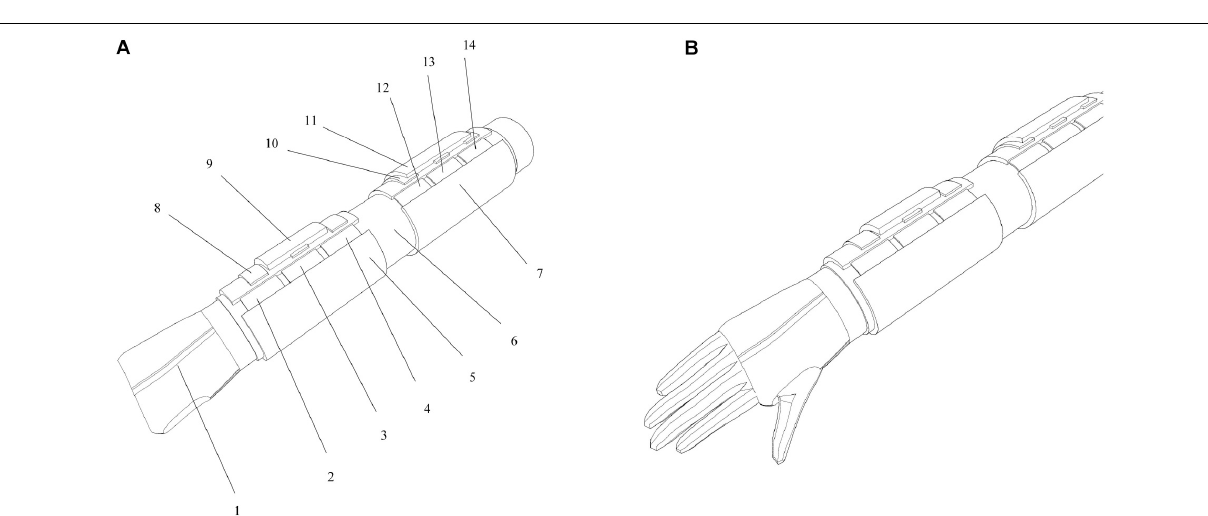
Frontiers in Bioengineering and Biotechnology |